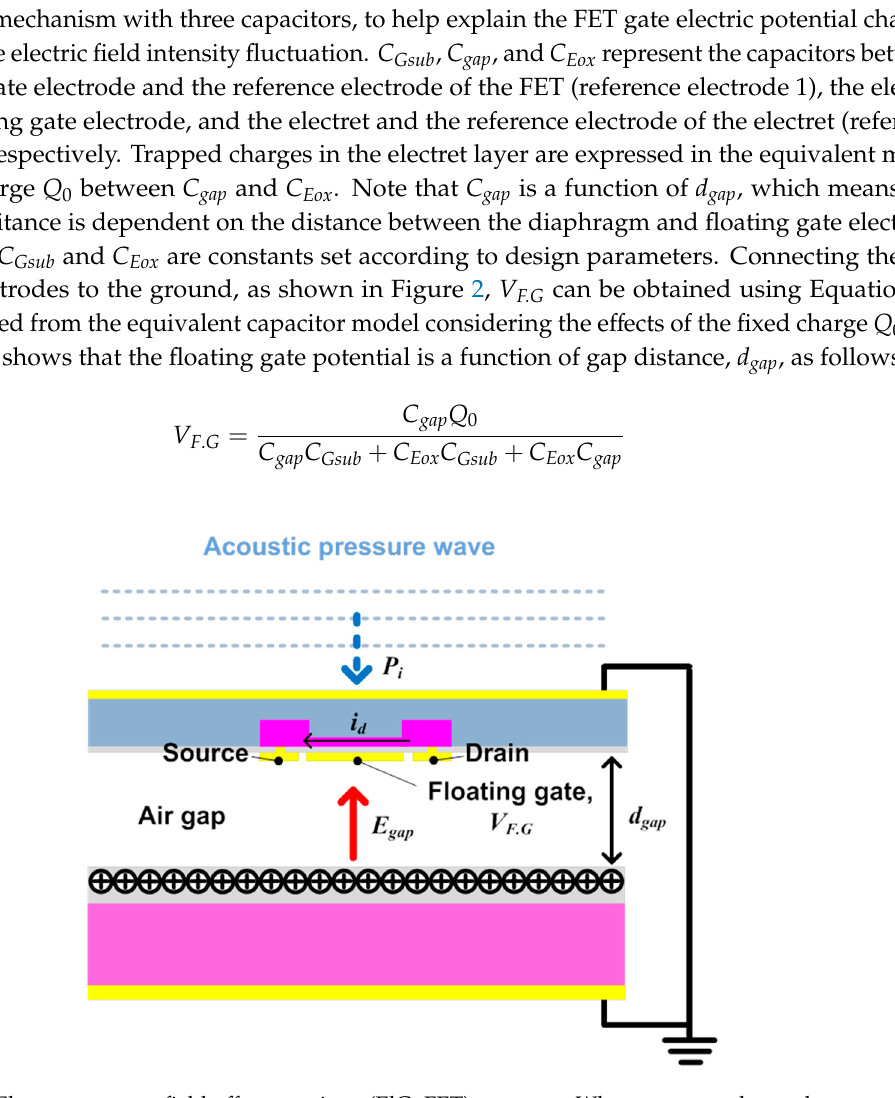
Figure 1. Electret gate on a field-effect transistor (ElGoFET) structure. When an external sound pressure wave is applied to the FET-embedded membrane, the gap between the FET gate and electret changes, such that the electric field applied to the FET gate fluctuates. This fluctuating electric field causes a change in the source–drain current, which represents the sound pressure wave.